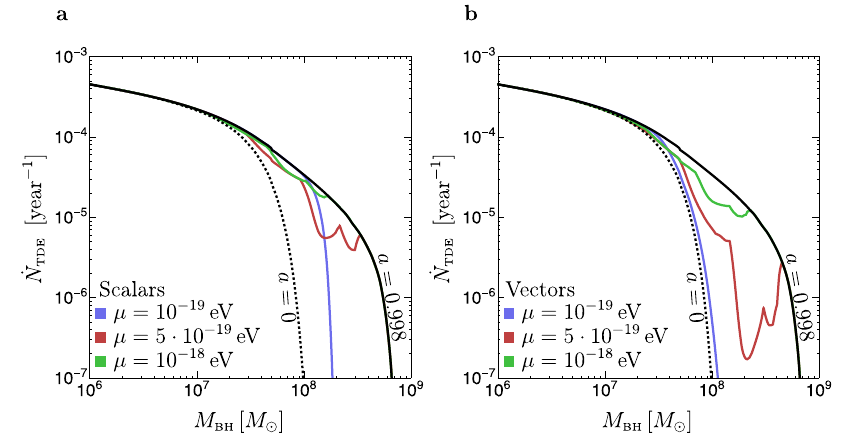
have the maximal spins allowed by thin-disk spin-up ( a =0.998) and superradiant spin-down, for different ULB masses. Panels a and b correspond to scalars and vectors. The spin dependence of the TDE rates is taken from ref.